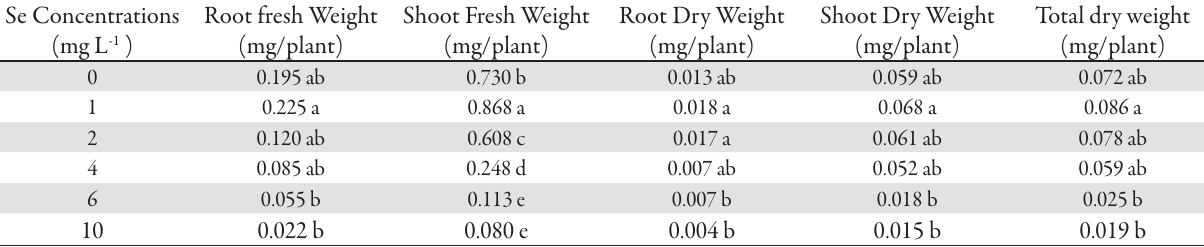
Tab. 1. Effect of selenium supplementation on some growth parameters of spinach plants Se